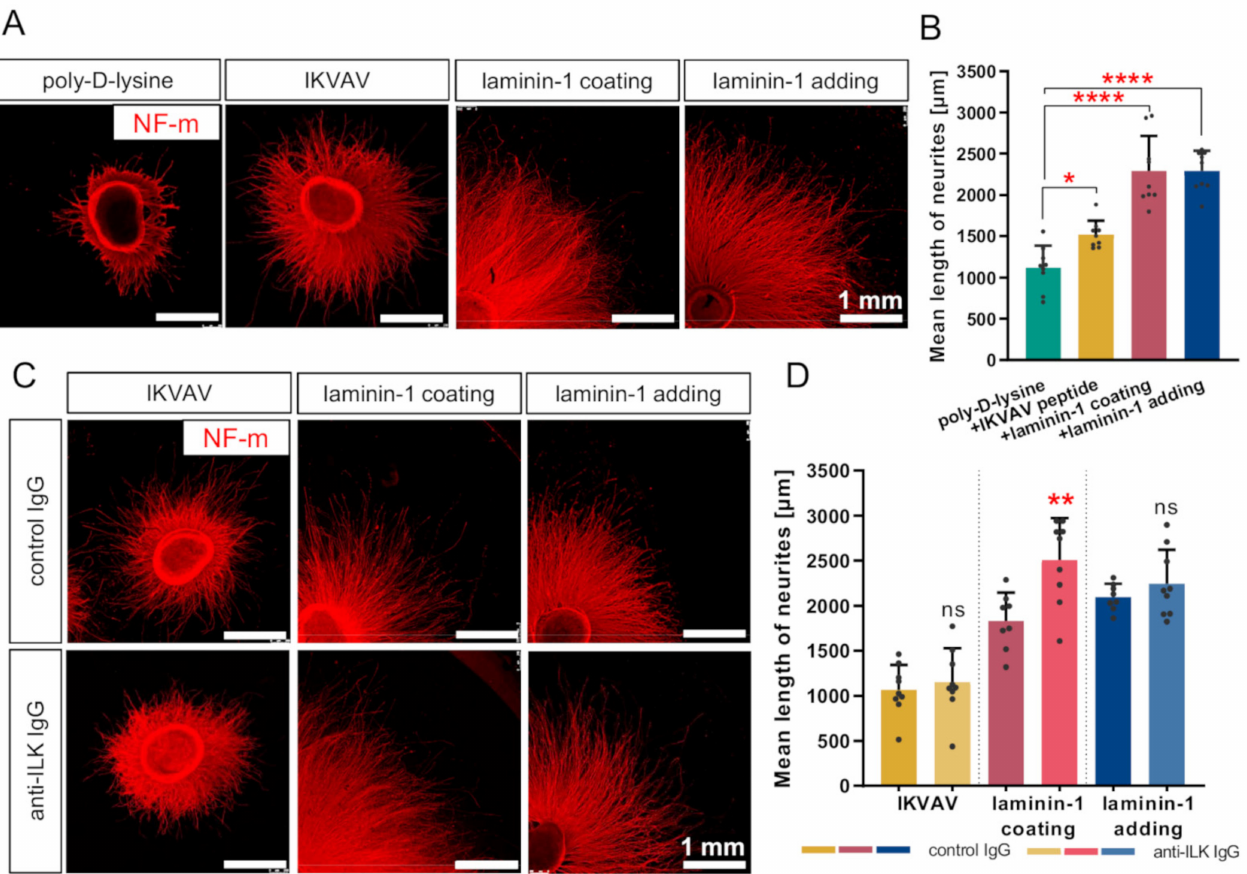
Figure 4. ILK plays a role in laminin-1-mediated DRG neurite outgrowth. DRG were cultured on a laminin-1-coated surface or with addition to a medium of IKVAV peptide or laminin-1 for 48 h. Separately, control or anti-ILK antibodies were added to the medium. Next, DRG were immunostained against NF-m to detect DRG neurites. ( A ) Representative images of DRG immunostained with anti-NF-m antibodies illustrating the DRG neurite outgrowth; ( B ) Quantification of DRG axonal outgrowth; p ≤ 0.05 (*); p ≤ 0.0001 (****); ( n = 9); ( C ) Representative images of DRG immunostained against anti-NF-m, showing the DRG neurite outgrowth upon alteration of ILK’s function; ( D ) Quantification of DRG axonal outgrowth upon affecting of ILK’s action; p ≤ 0.01 (**); ns—not significant; ( n = 9). Quantitative data ( B , D ) are presented as mean ± SD for ten the longest neurites per each of the nine DRG explants. Individual points represent averaged values obtained from the analysis of each